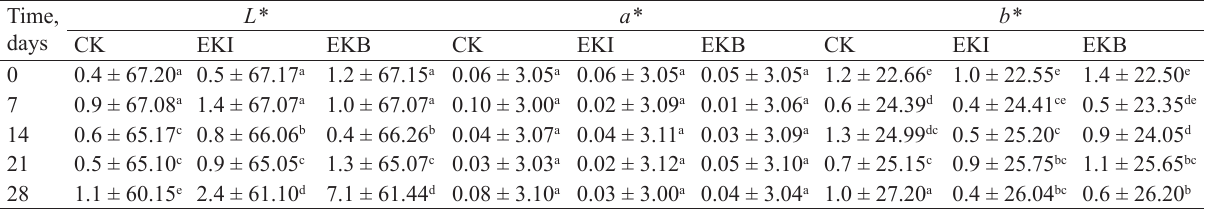
Table 6 Colorimetric characteristics of kashk samples